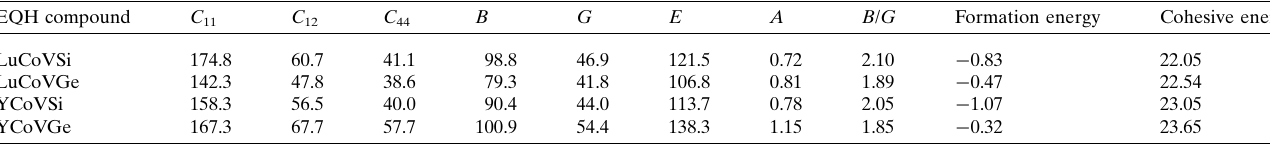
Table 3 Calculated elastic constants C ij , bulk modulus B , shear modulus G , Young’s modulus E (GPa), anisotropy factor A , Pugh’s ratio B / G , and formation and cohesive energies (eV) for the EQH compounds M CoV Z ( M = Lu, Y; Z = Si, Ge) with type III structure.